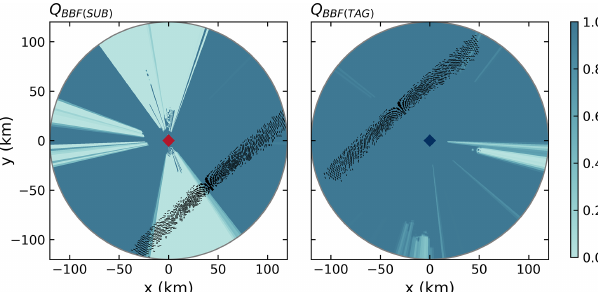
Figure 3. The beam blockage quality index ( Q BBF ) for the two radars is shown in the background for 0.5 ◦ elevation angle. Black points show the locations of matched bins between SUB and TAG for each radar coverage, using the example of an elevation angle of 0.5 ◦